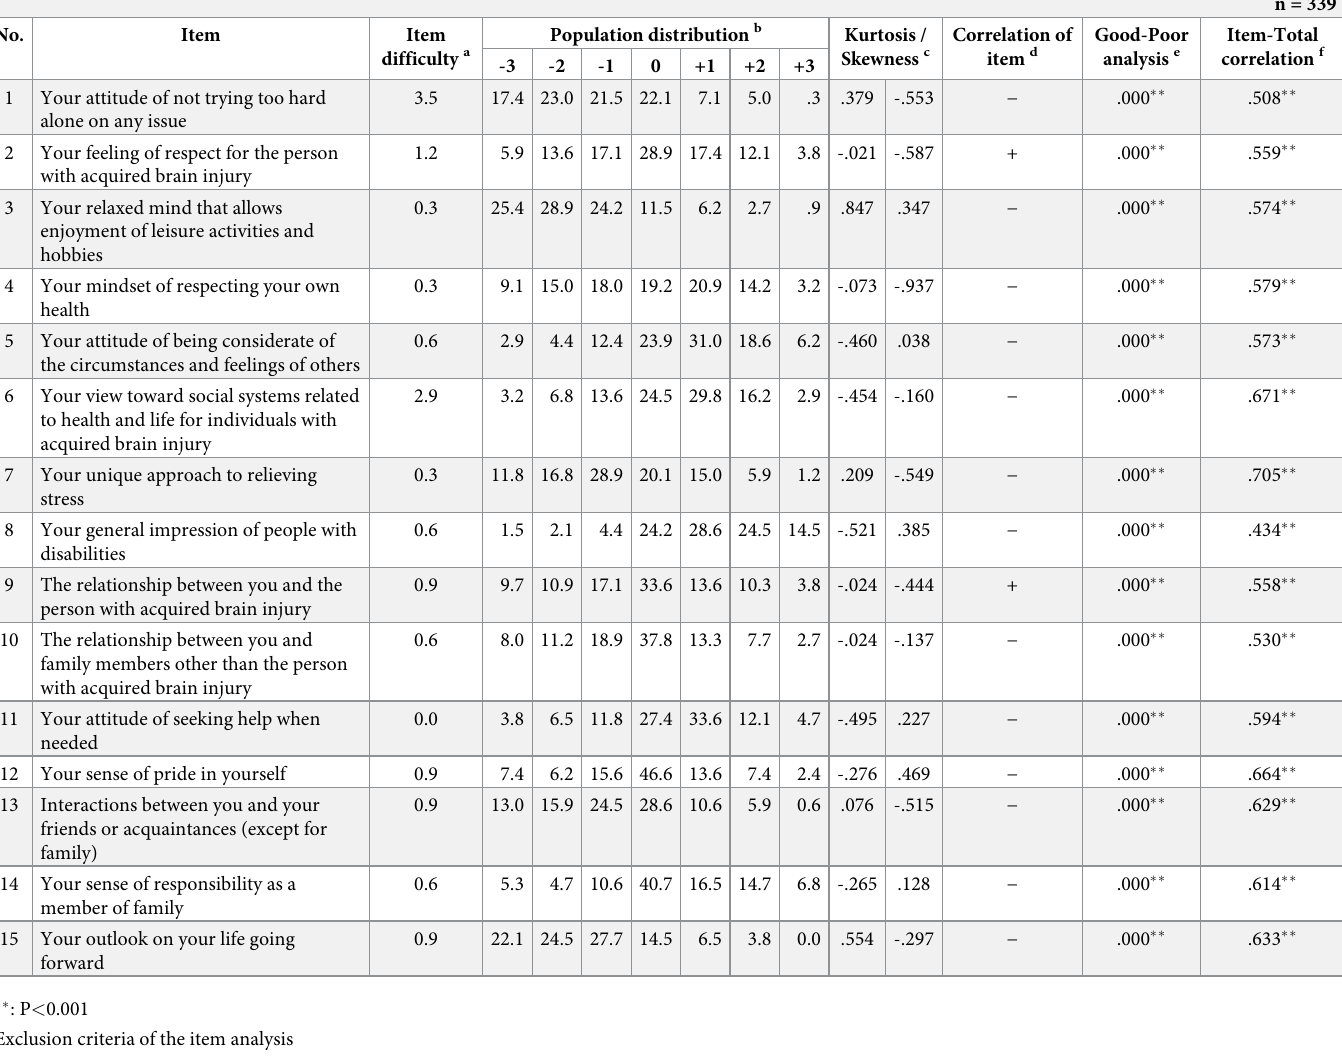
Table 3. Item analysis of “the life change adaptation